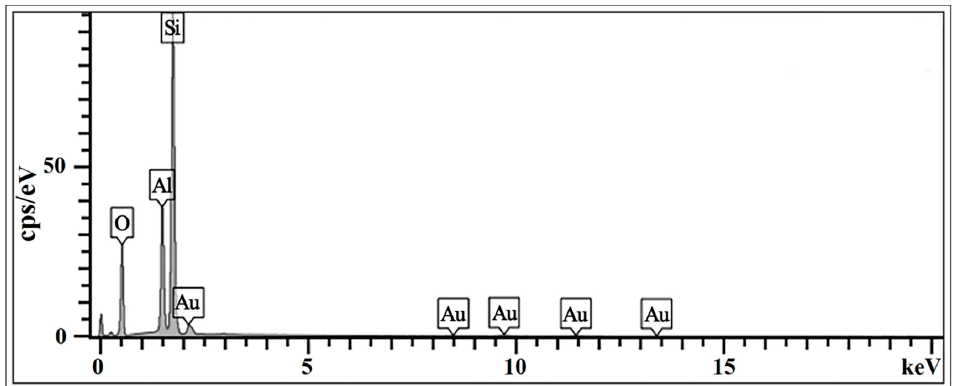
Figure 3. EDS mapping images of Al–SiO 2